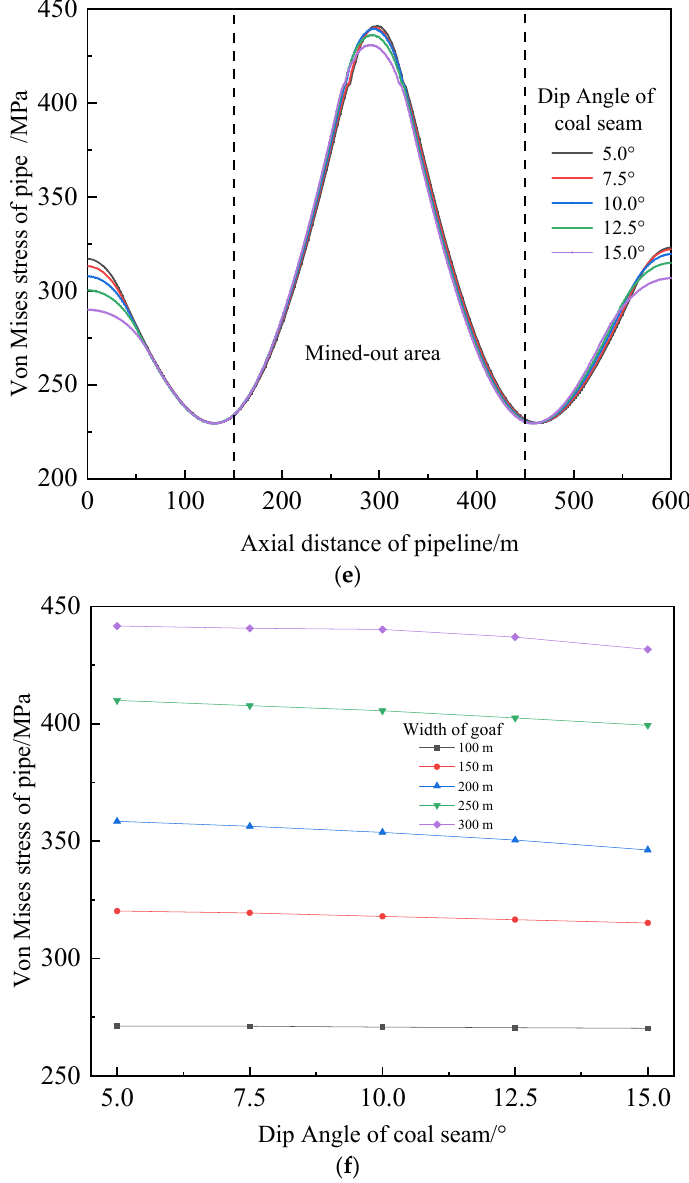
Figure 9. Von Mises stress curves of the pipe for different coal-seam dip angles. ( a ) Goaf width of 100 m. ( b ) Goaf width of 150 m. ( c ) Goaf width of 200 m. ( d ) Goaf width of 250 m. ( e ) Goaf width of 300 m. ( f ) Maximum von Mises stress of the pipe.